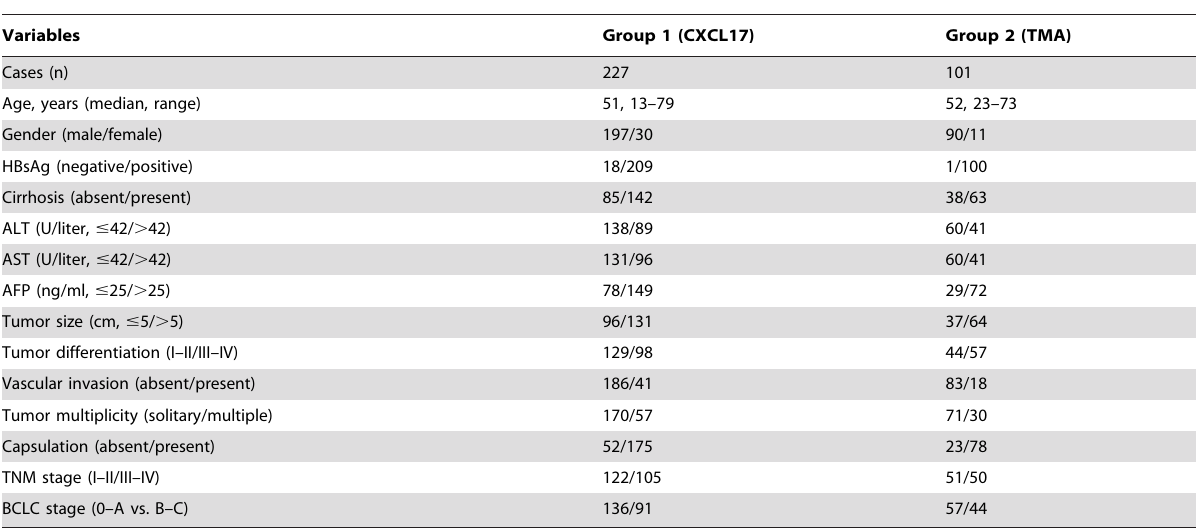
Table 1. Clinical characteristics of 227 patients with